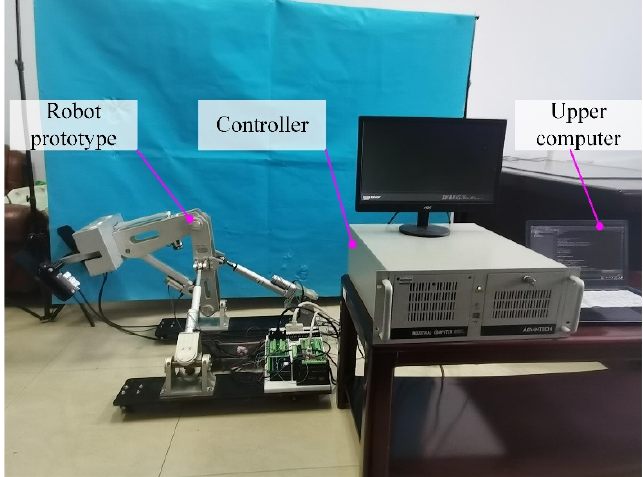
Figure 9. Frame diagram of lower limb rehabilitation robot control system.